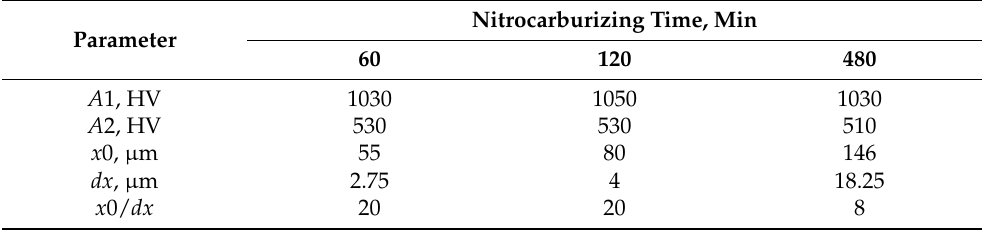
Table 7. The parameters of the in-depth hardness distribution function calculated from surface hardness for the three nitrocarburizing